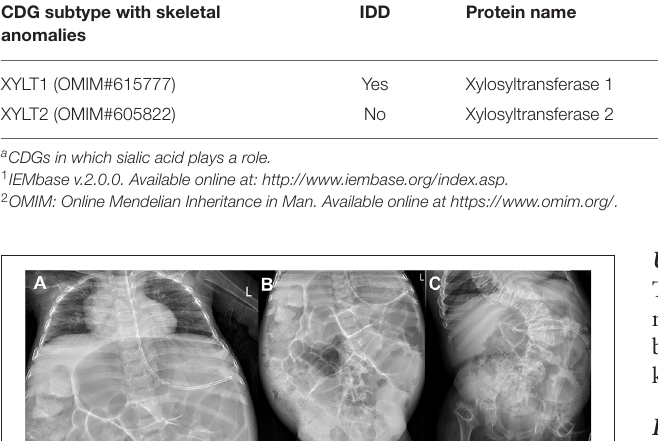
macrocephaly ( n = 2/9; 22%) ( Figure 2 ). Over time, the face may appear